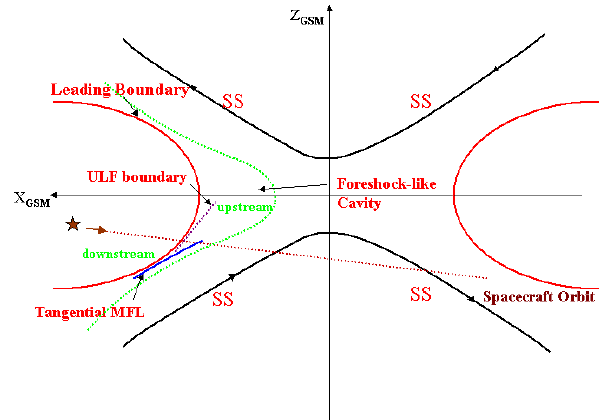
Fig. 2. A schematic of the reconnection layer encountered by the spacecraft and the boundaries in the cavity. The two black curves represent the pair of slow-mode separatrices. The dashed green line depicts the local magnetic configuration of the field line piled up region. The red curve in the left-side describes the shock front, i.e., the sharp leading edge of the ion jet. The blue line signifies the magnetic field line tangent to the quasi-perpendicular shock front. The star and the dashed brown line denote the spacecraft and its orbit. More details can be founded in the